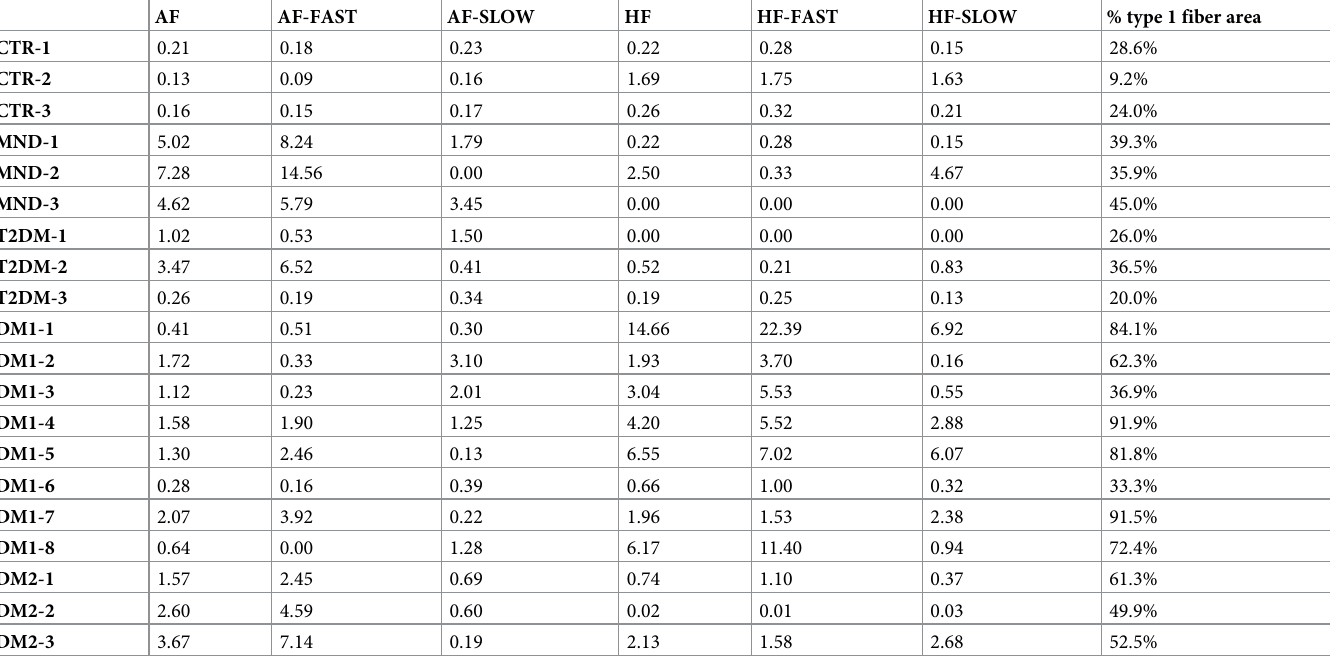
Table 2. Atrophy and hypertrophy factors of skeletal muscles used in this study.